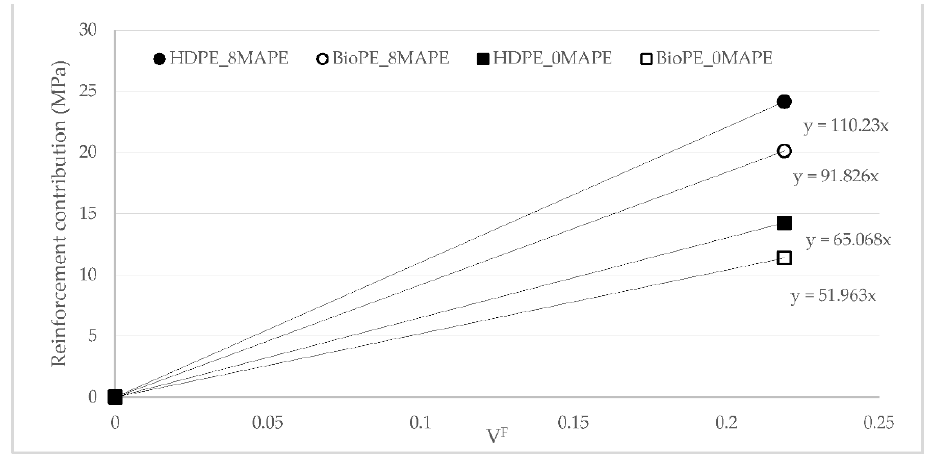
Figure 6. Fiber Tensile Strength Factor (FTSF) for coupled and uncoupled HDPE and BioPE AF reinforced composites.